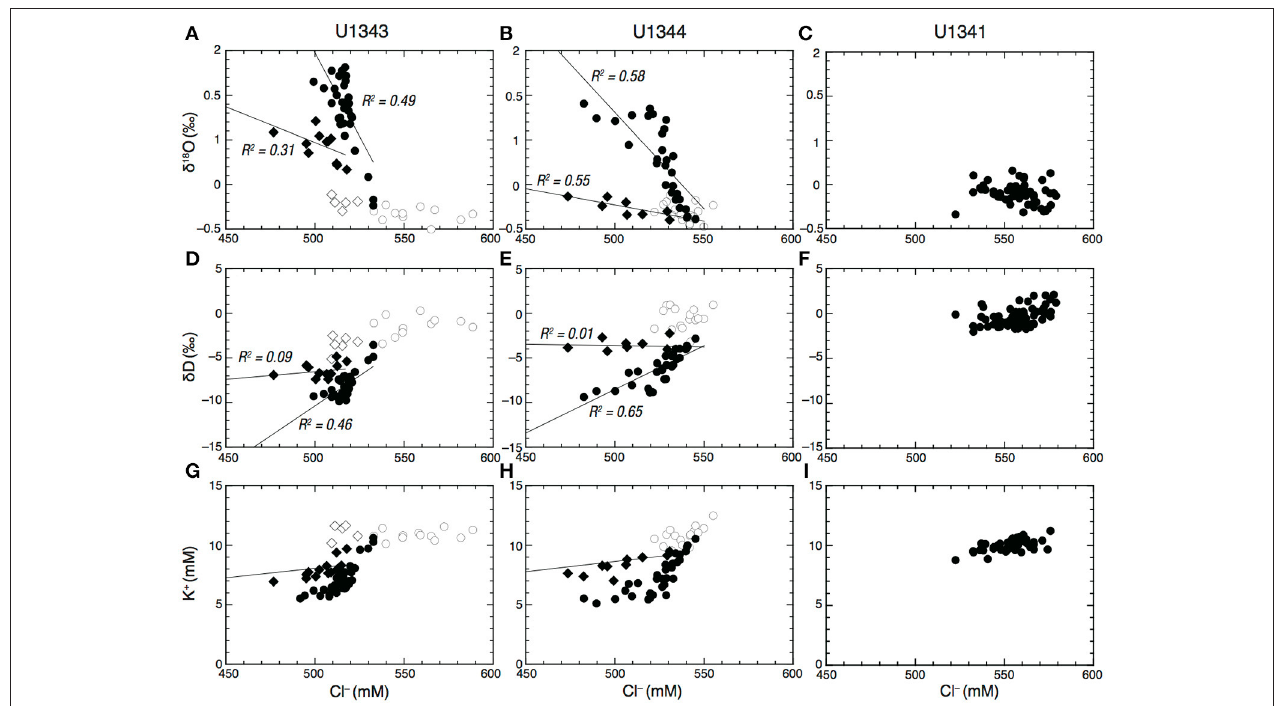
FIGURE 4 | Cl − vs. δ 18 O (A–C) , δ D (D–F) , and K + (G–I) in porewater at Sites U1341, U1343, and U1344, respectively. Open circles in (A,B) , (D,E) , and (G,H) show samples shallower than 120–140 mbsf at Sites U1343 and U1344. Open diamonds in (A,B) show discrete low Cl − spikes shallower than 200 mbsf at U1343. Filled diamonds show discrete low Cl − spikes between 200 mbsf and 450 mbsf at Sites U1343 and U1344. Solid lines in (A,B,D,F) show regression lines. Solid lines in (G) and (H) show the expected dilution line of seawater by freshwater.